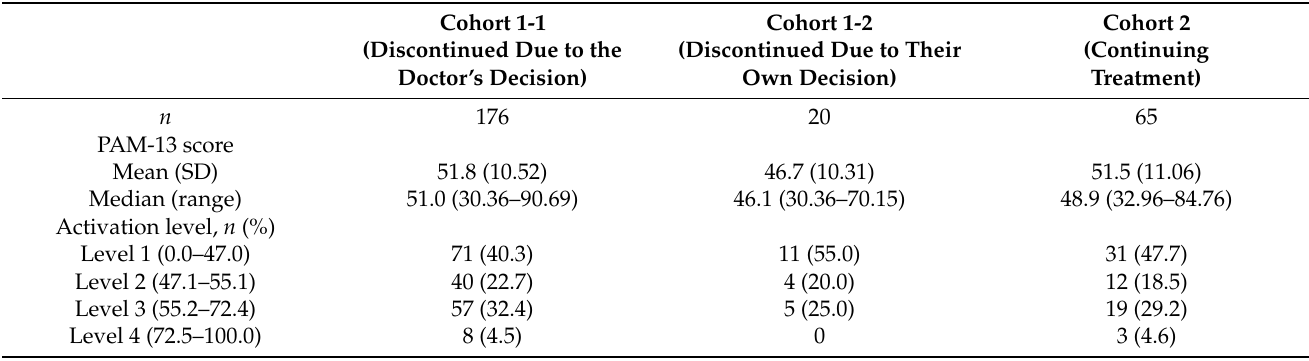
Table 6. Distribution of patient activation